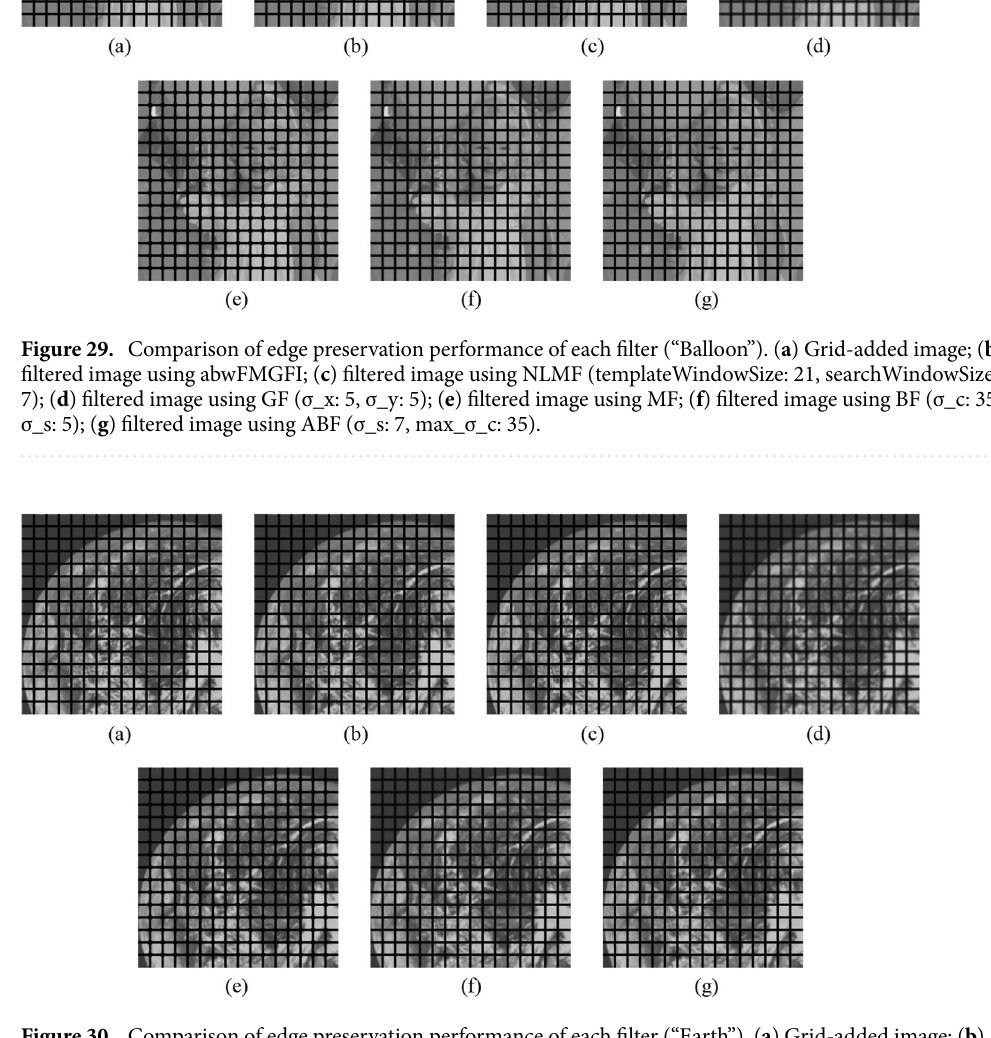
Figure 30. Comparison of edge preservation performance of each filter (“Earth”). ( a ) Grid-added image; ( b ) filtered image using abwFMGFI; ( c ) filtered image using NLMF (templateWindowSize: 21,